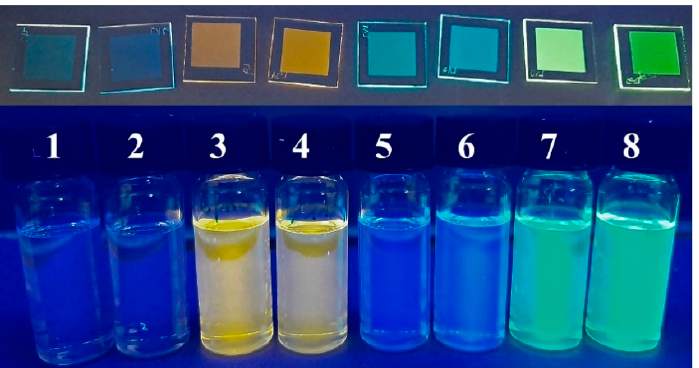
Figure 3. Thin films and solutions of the alkylated flavin derivatives illuminated with monochromatic light at 366 nm.